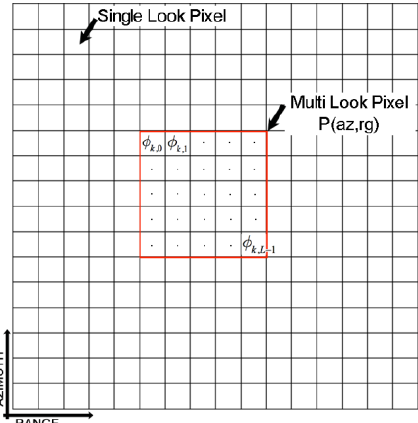
Figure 5. Sketch of the pixel grid of the k-th interferogram exploited for spatial multi-look operations. In the red box are highlighted the single-look phases used for the computation of the variance relative to the generic multi-looked pixel P of radar coordinates (az,rg).